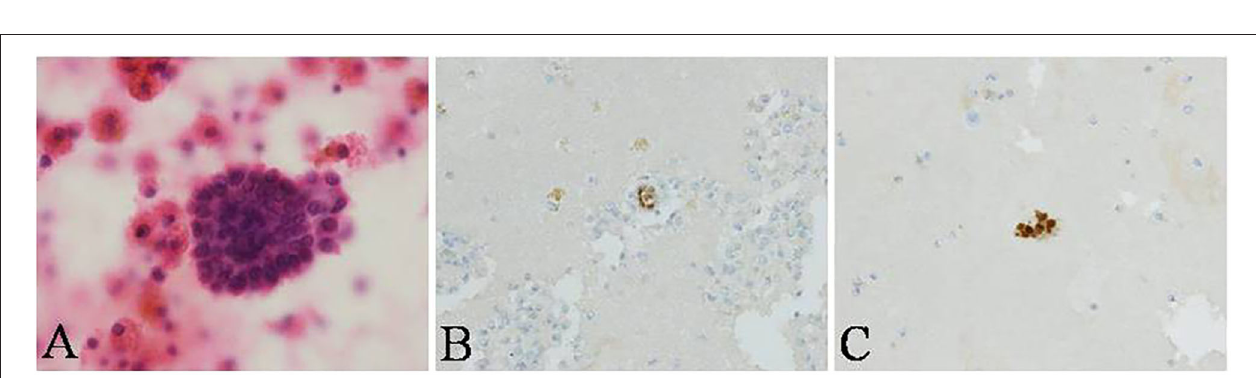
FIGURE 3 | Cytological examination of pleural fluid in the patient. (A) scattered clusters of endometrial glandular cells (ThinPrep TM , H&E stain, × 400) in pleural fluid, showing nuclear positivity for (B) estrogen receptor and (C) progesterone receptor with immunohistochemical staining (conventional smear, × 400).